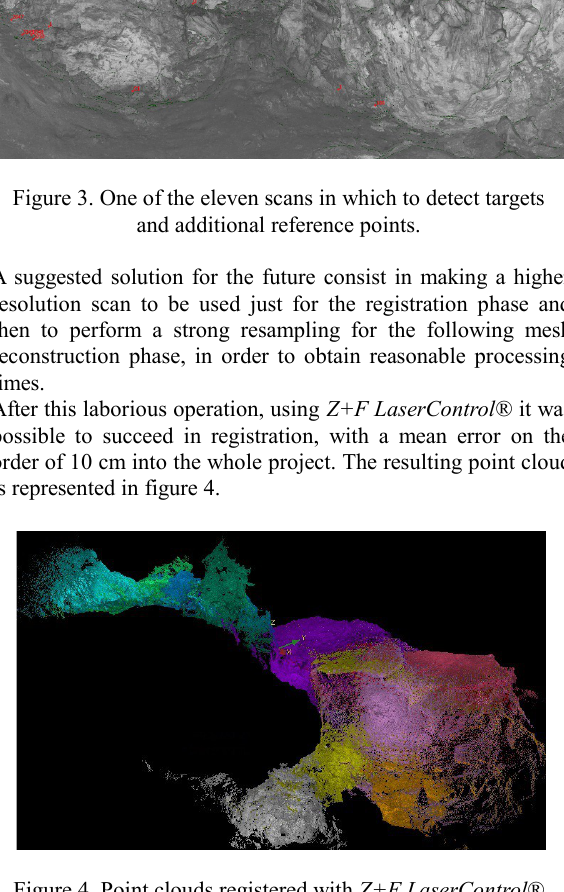
Figure 4. Point clouds registered with Z+F LaserControl ®. Each colour corresponds to a different point